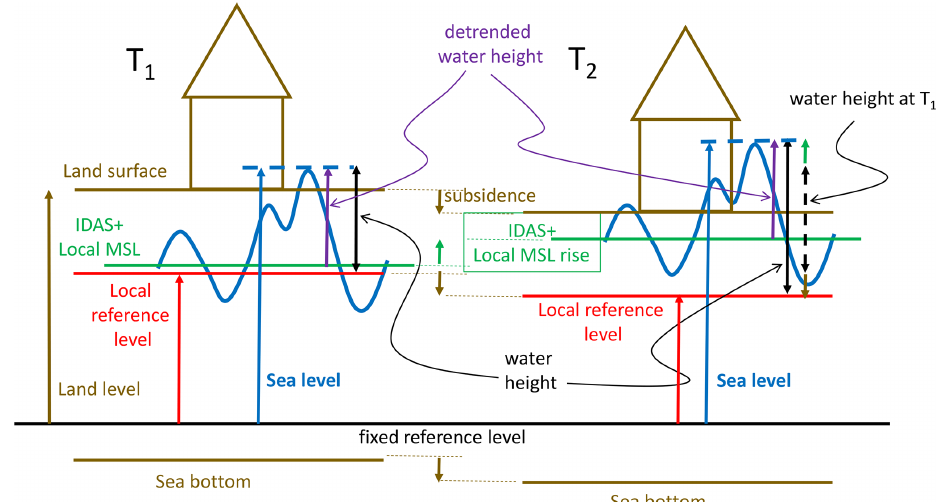
Figure 2. Schematic showing changes in water height for a hypothetical identical event occurring at time T 1 (mid-20th century) and T 2 (first decades of the 21st century). Local subsidence has shifted the land surface, the reference level, and the sea bottom to a lower level. RSL rise and IDAS have shifted the sea surface to an upper level. The water height of the same event hypothetically measured at T 1 and T 2 differs by the IDAS and RSL rise contribution. The latter is split into local subsidence and mean sea level rise. The detrended water height is the addition of the meteorological surge (storm surge, PAW surge, meteotsunamis), astronomical tide, and